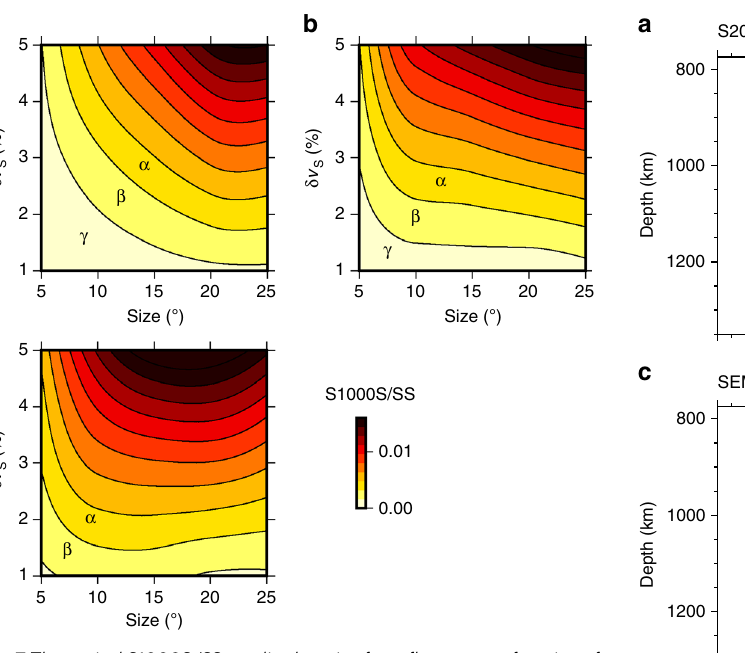
Fig. 7 Theoretical S1000S/SS amplitude ratios for re fl ectors as a function of lateral size and shear-wave velocity contrast. a 25° bins. b 15° bins. c 10° bins. Re fl ectors are introduced at 1000 km depth and centred on the SS bounce point, for an event-receiver epicentral distance of 125°. The contours correspond to the S1000S/SS amplitude ratio, as measured in cross-sections through the stacked vespagrams. Contour γ marks the realistic limit of observability. Contour α is not detectable, and Contour β is observable only in extremely high-quality data. This is estimated from our data, whereby the minimum observable SdS/SS amplitude ratio is approximately 0.0065